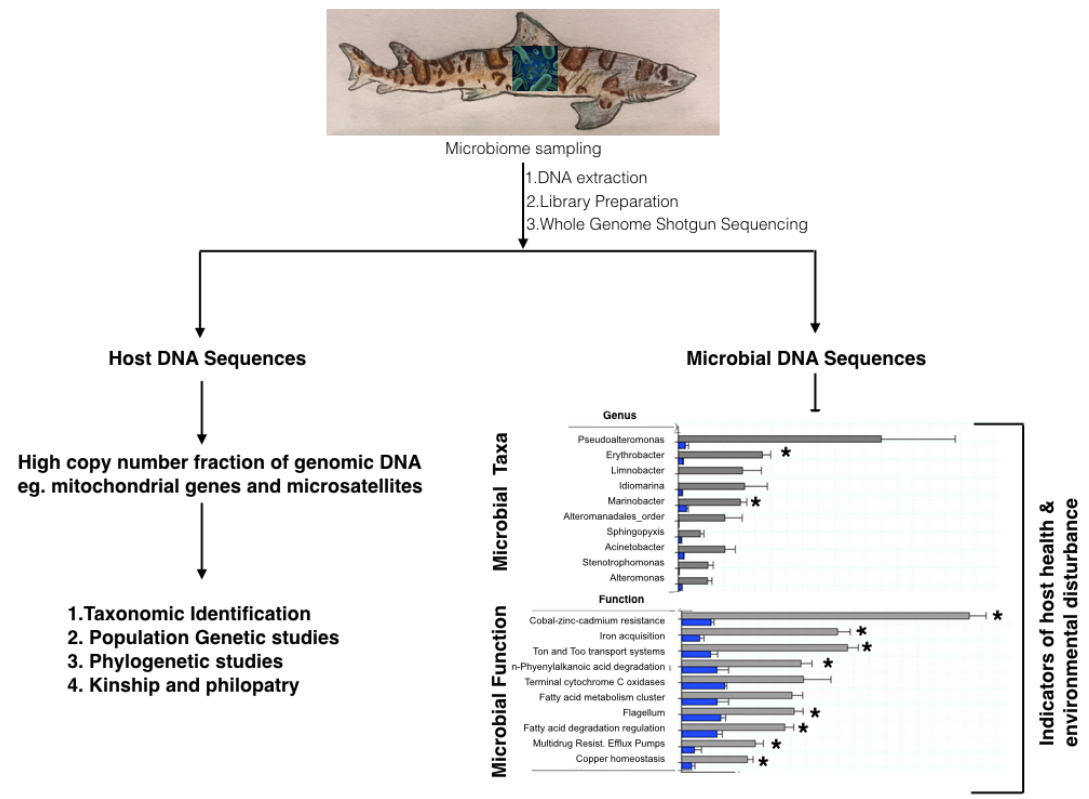
Figure 2. Microbiomes facilitate understanding of host genomics, host-microbe interactions and host physiology. Microbiome analyses using whole genome shot-gun metagenomics allows access to genomic information along with an understanding of microbial taxonomic and functional diversity. Host genomes thus obtained provide a non-invasive means for taxonomic identification, phylogenetic analyses, population genetic and kinship studies. A description of microbial taxa and function, facilitate understanding of host physiology and health and provide a non-invasive monitoring tool for longitudinal studies in chondrichthyan populations. The graphs above, adapted from [99] Doane et al., 2017 provide a description of microbial taxa and function associated with thresher sharks (grey) and sea water (blue).